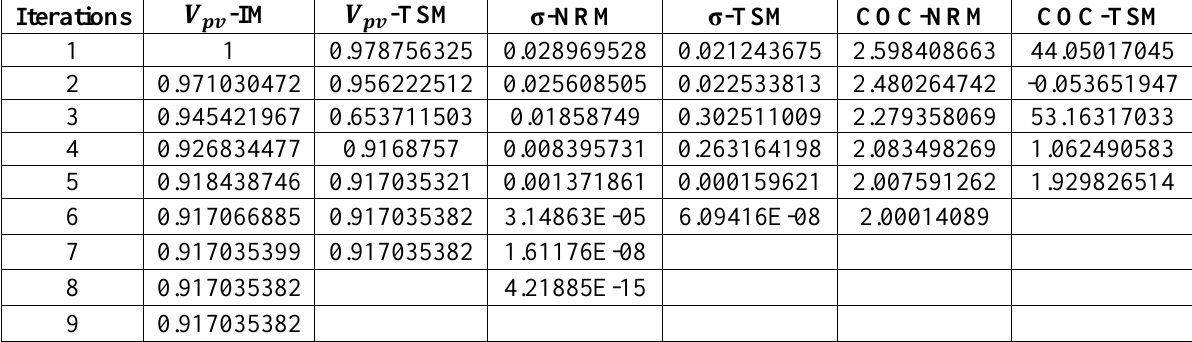
Table 2: The obtained values using NRM and TSM